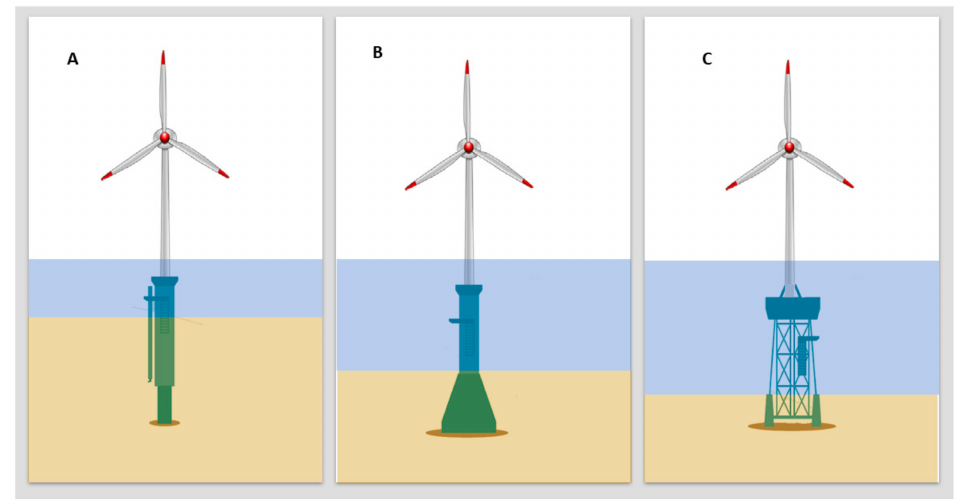
Figure 1. Fixed foundations: ( A ) Monopile. ( B ) Gravity. ( C ) Jacket.